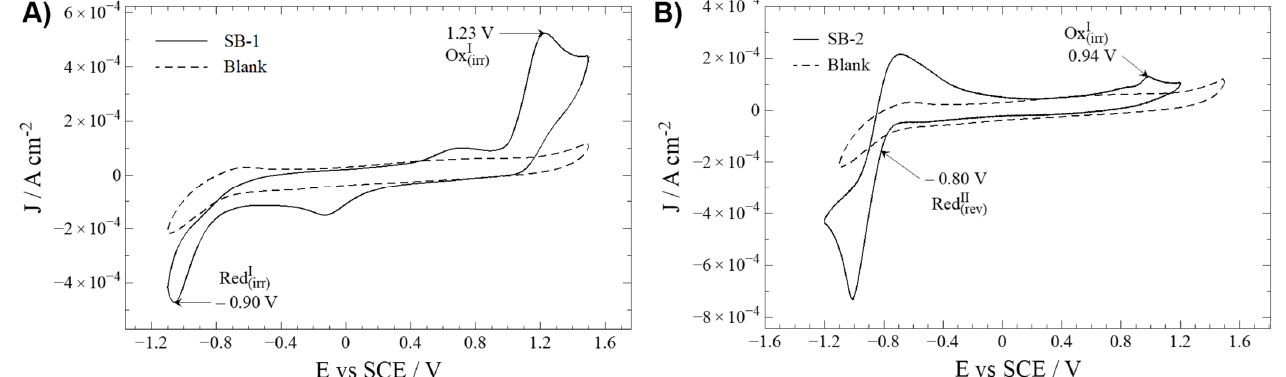
Figure 2. Cyclic voltammetry profiles of Schiff bases (—) and blank (---). Interface: Pt| 10 − 3 mol L − 1 of compound + 10 − 1 mol L − 1 of TBAPF 6 in anhydrous CH 3 CN under an argon atmosphere. Scan rate: 200 mV s − 1 . ( A ) SB-1; ( B ) SB-2.